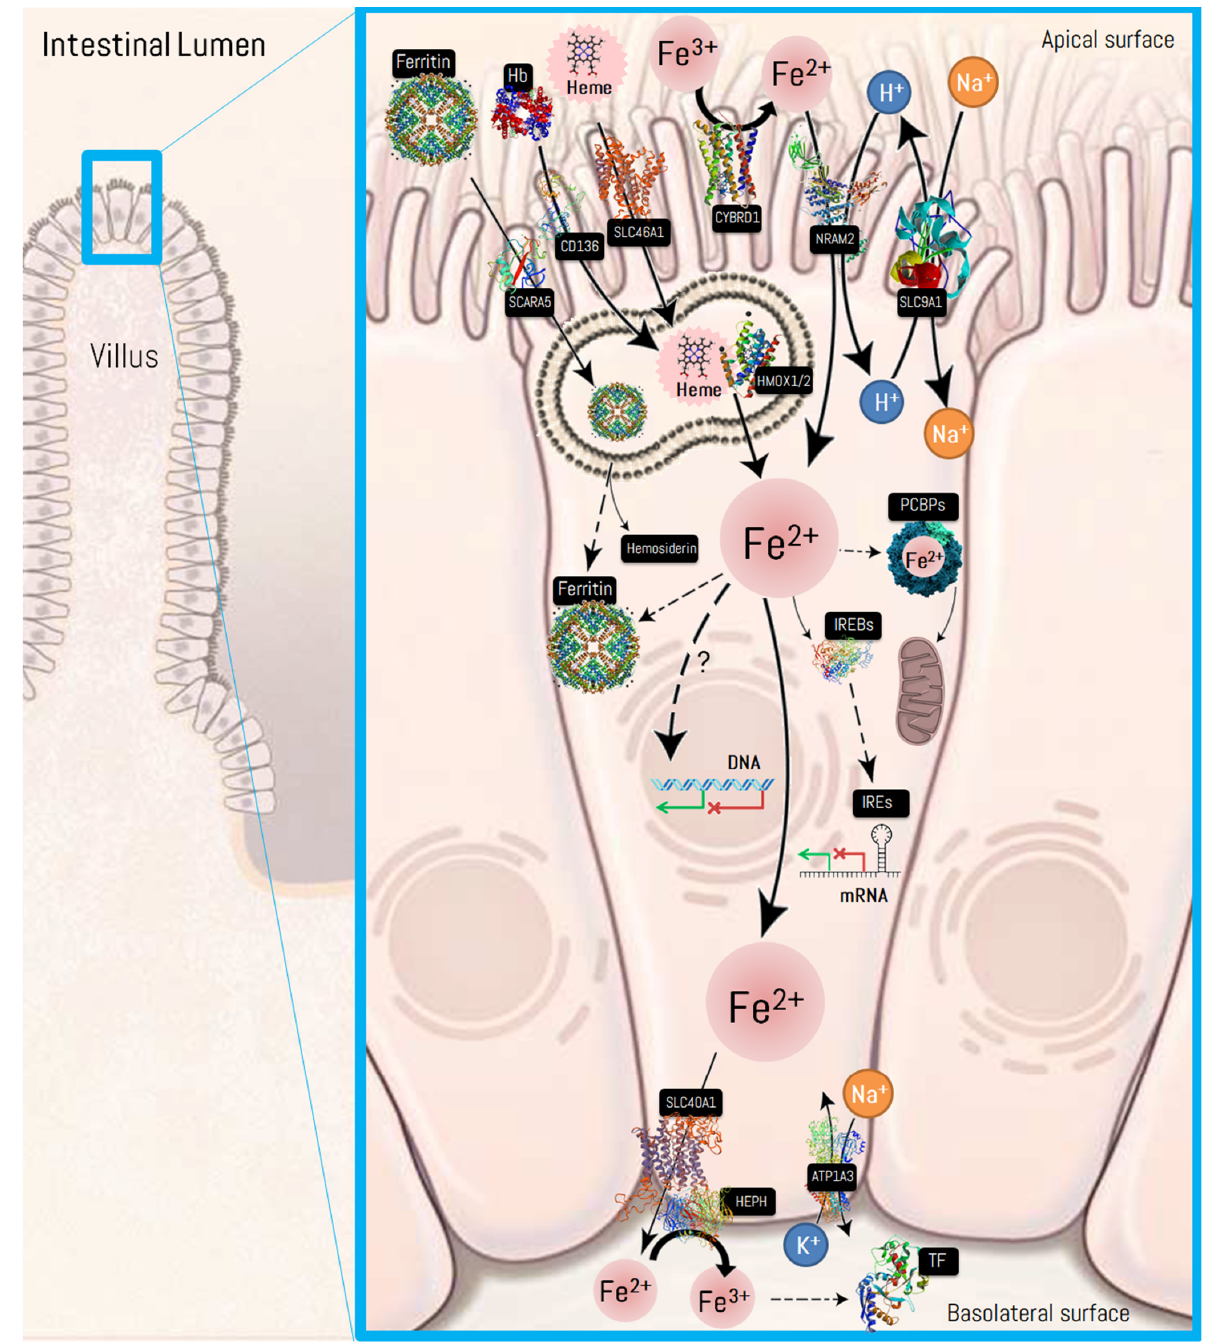
Figure 3. Iron absorption in the duodenum. The protein structures were taken from UniProtKB and PDB repositories. Structure prediction by homology modeling was carried out using SWISS-MODEL via the ExPASy web server if the protein structure was not available at UniProtKB or PKB. ATP1A3, basolateral sodium/potassium-transporting ATPase; CD163, scavenger receptor cysteine-rich type 1 protein M130; CYBRD1, cytochrome b reductase 1; CP, ceruloplasmin; Hb, hemoglobin; HEPH, hephaestin; HMOX1/2, heme oxygenases 1/2; IREBs, iron-responsive element-binding proteins; IREs, iron-responsive elements; mRNA, messenger RNA; NRAM2, natural resistance-associated macrophage protein 2; PCBP, poly(rC)-binding protein; SCARA5, scavenger receptor class A member 5; SLC9A1, apical sodium/hydrogen exchanger 1; SLC40A1, solute carrier family 40 member 1; SLC46A1, proton-coupled folate transporter; TF, transferrin. Source: designed by the authors